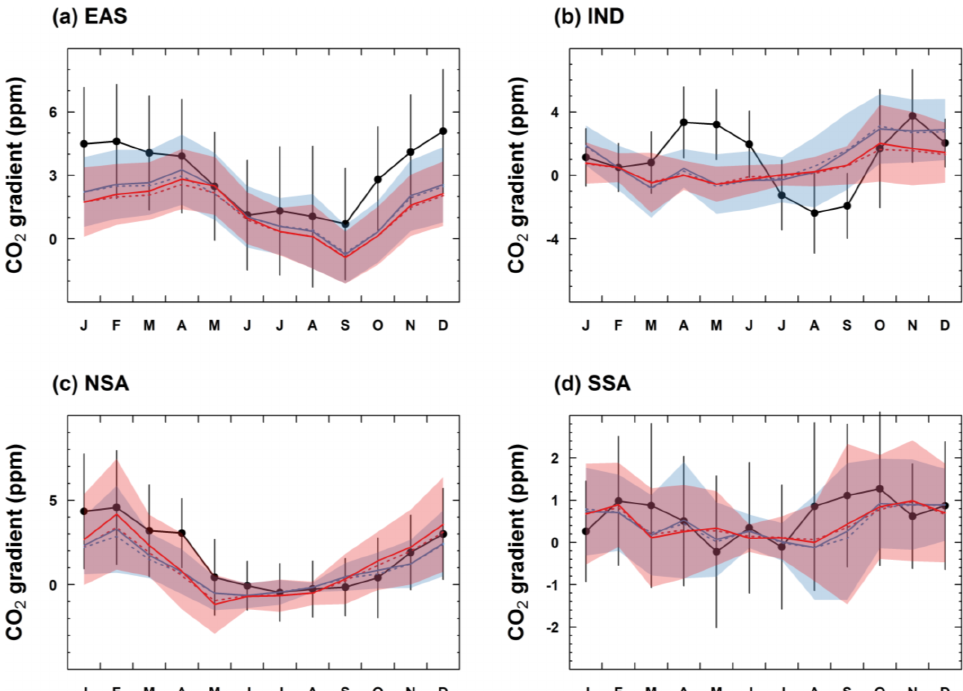
Figure 7. Monthly mean observed and simulated CO 2 gradient between 1 and 4km over (a) East Asia (EAS), (b) the Indian subcontinent (IND), (c) northern Southeast Asia (NSA) and (d) southern Southeast Asia (SSA). For each subregion, the monthly CO 2 gradients are calculated by averaging the differences in CO 2 concentrations between 1 and 4km over all the vertical